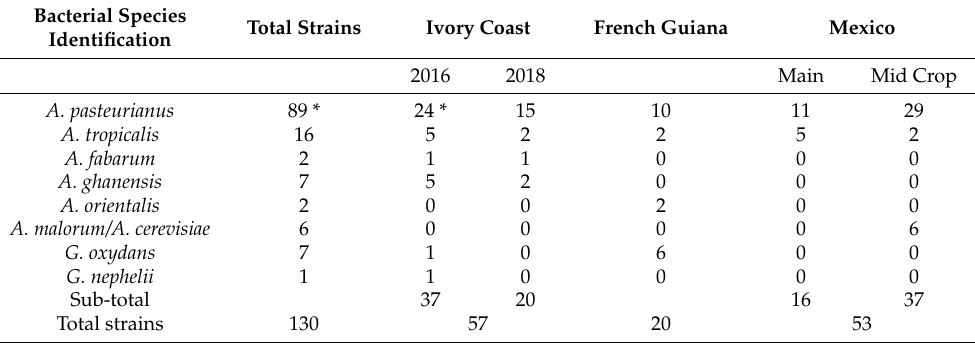
Table 2. Molecular identification of the 130 AAB strains by 16S rRNA gene sequencing and the repar- tition of the isolates according to the three countries: Ivory Coast, French Guiana, and